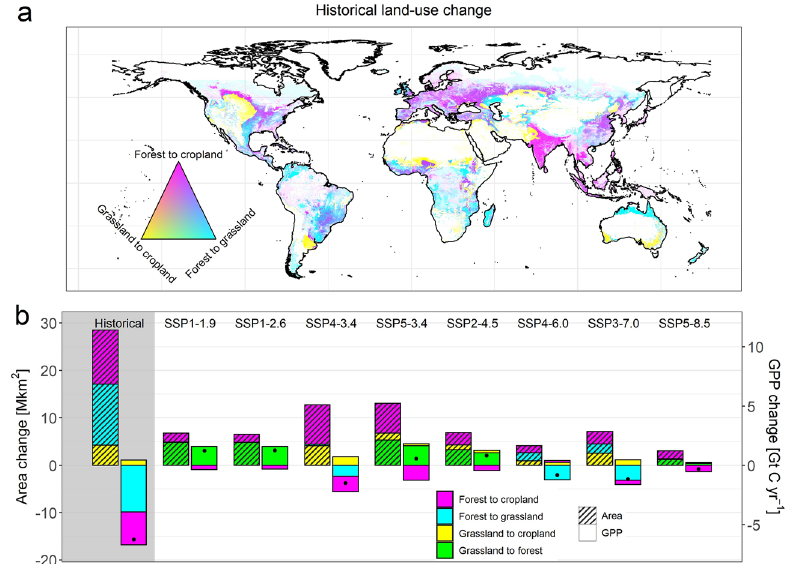
Figure 2. Land cover change impacts on GPP. ( a ) Map of historical (until year 2015) land cover transitions based on LUH2 agricultural areas and potential forest cover calculated from ref. 31 . Shading indicates the converted fraction of a grid cell. ( b ) Global net land cover transitions as well as associated impacts on global GPP for the historical period (until year 2015, grey background) and future projections (2015–2100). The net impacts of all land cover transitions on global GPP are indicated by dots. The figure was created using R version 4.1.0 (https:// cran.r- proje ct. org/) 25